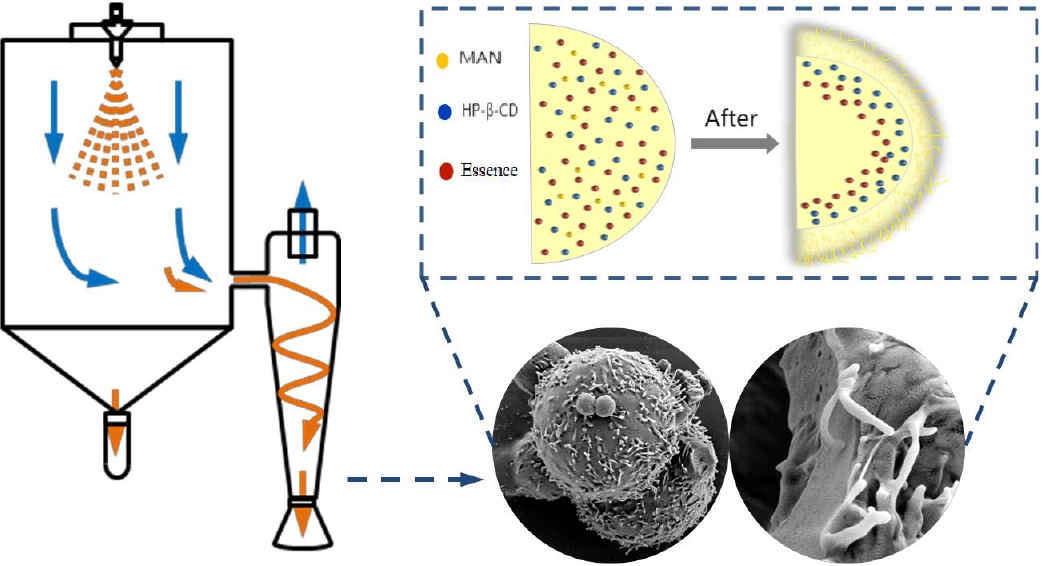
Figure 9. Morphology of HP- β -CD/MAN microcapsules during spray drying.